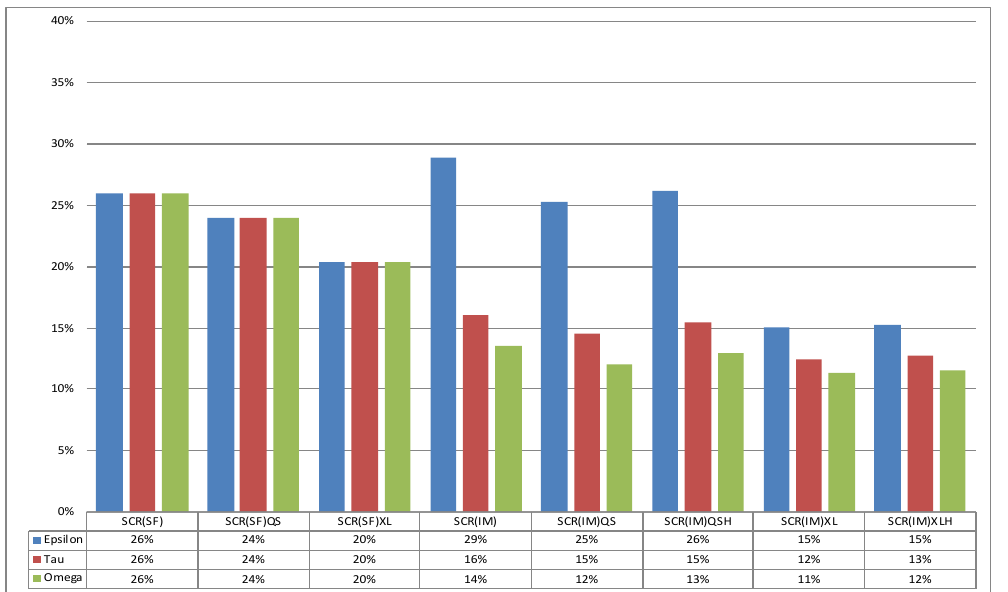
Figure 7. Baseline portfolio mix: ratio Solvency Capital Requirement